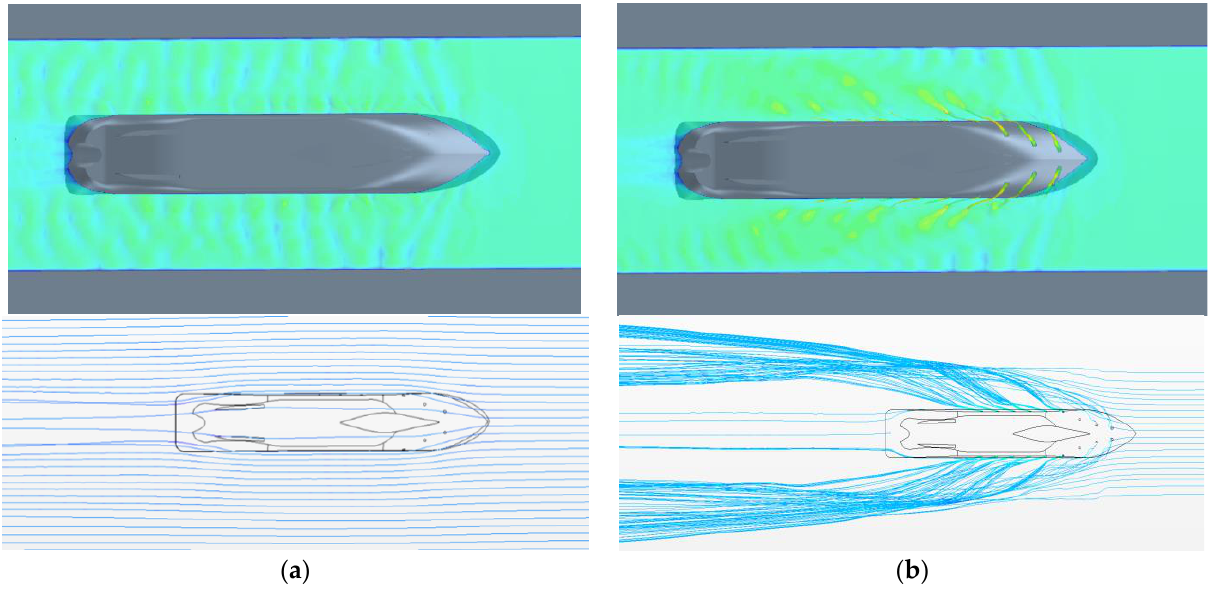
Figure 6. Wave patterns and streamlines around the hull for: ( a ) when the air-bubble system is turned off; ( b ) when the air-bubble system is activated.